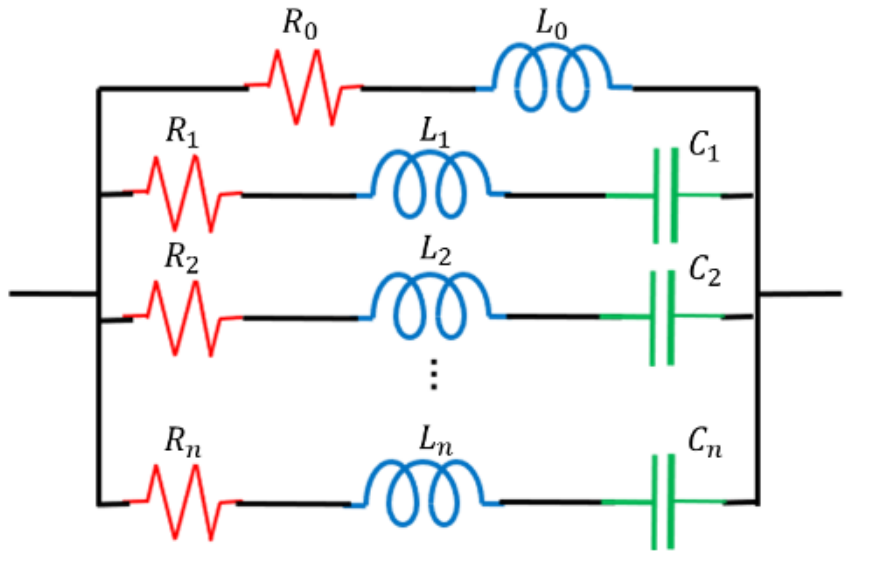
Figure 1. The equivalent circuit for loop resonator